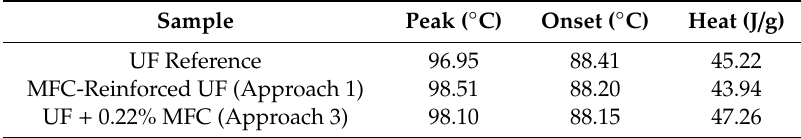
Table 14. DSC analysis results, Experiment 3.1.1 (Approach 1 vs. Approach